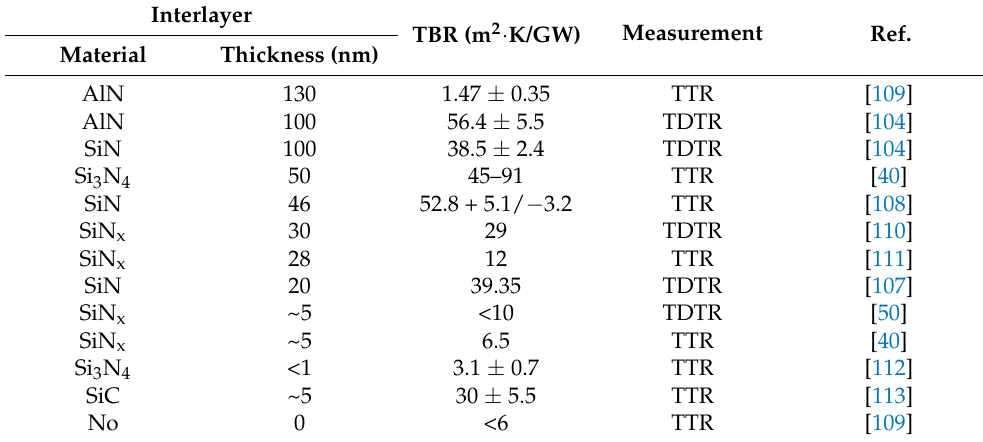
Table 4. Summary on the TBR eff at the interface of diamond on